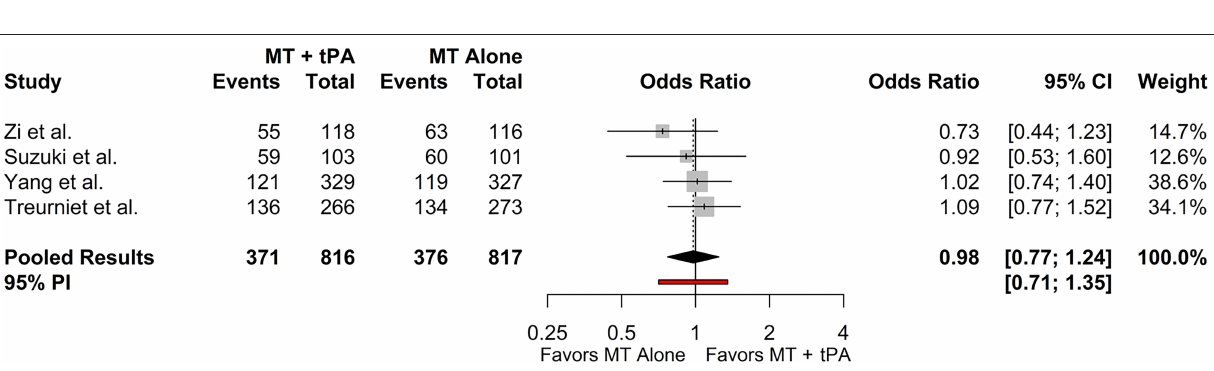
Frontiers in Neurology |